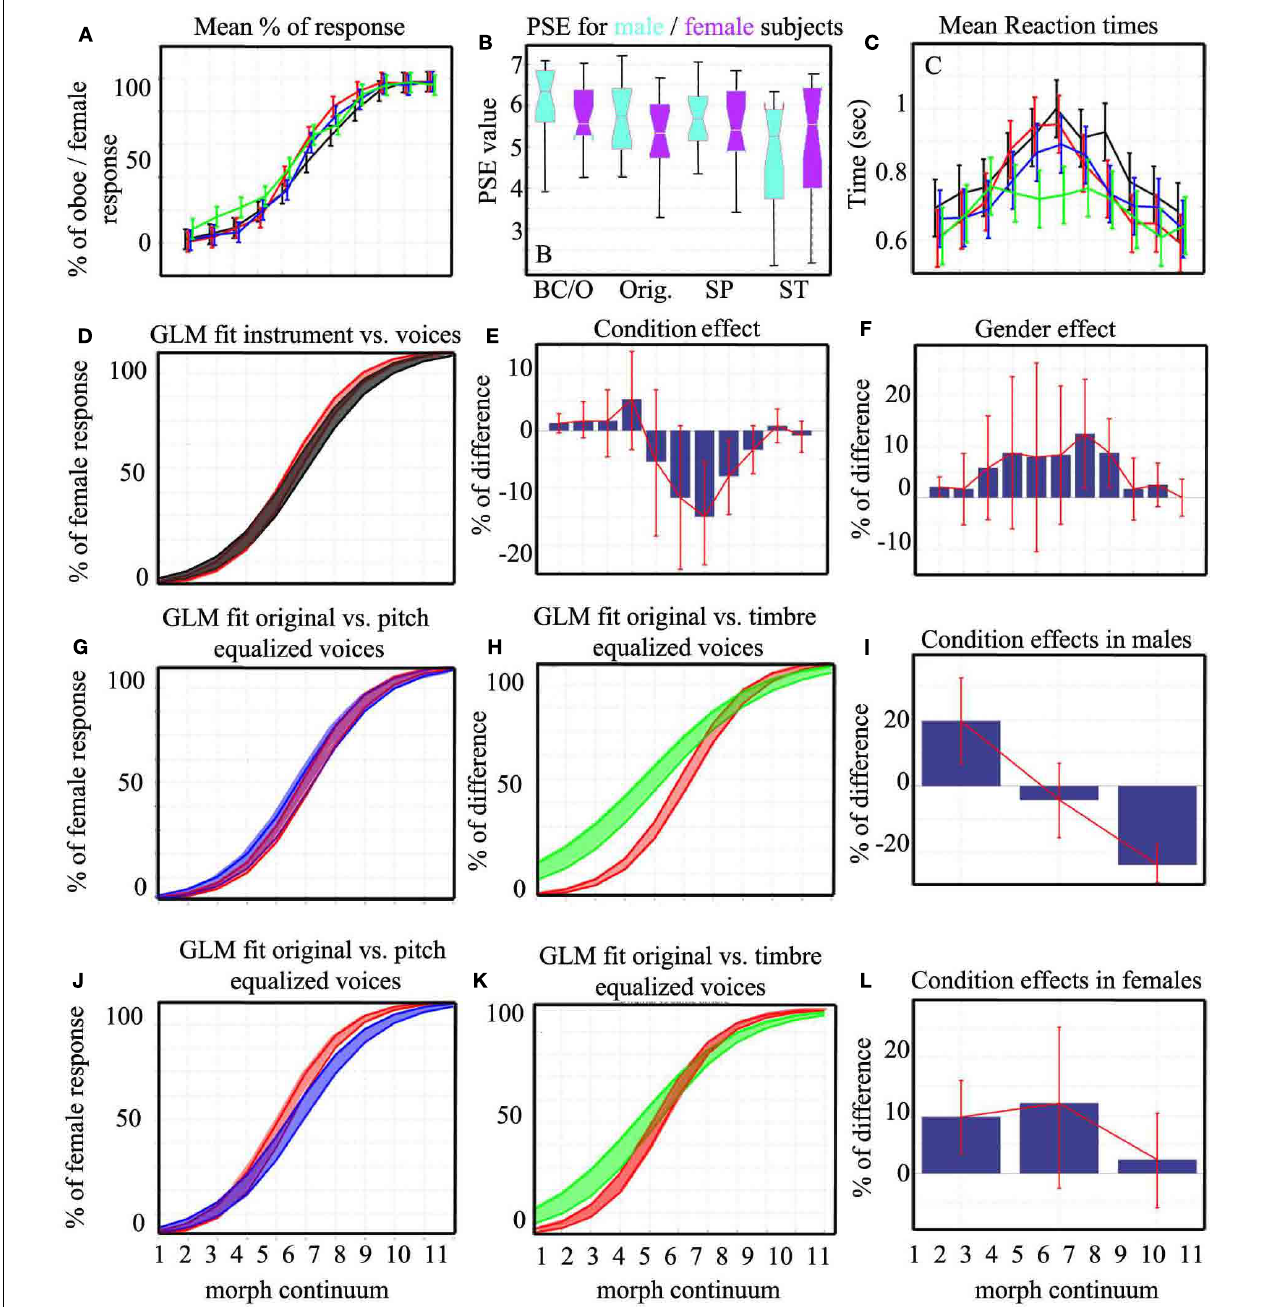
continua observed in male (G,H) and female (J,K) participants.The corresponding average differences between conditions (Orig.–SP, Orig.–ST, SP–ST) are shown in (I,L) .The color code follows Figure 6 : bass clarinet/oboe in black, original voices in blue, voices equalized in pitch in red, and voices equalized in timbre in green.The box plot for PSE shows the median and interquartile range with whiskers extending to the most extreme points. Bars represent 95% confidence intervals within subjects for mean responses and mean RTs and across bootstrap differences for pair-wise